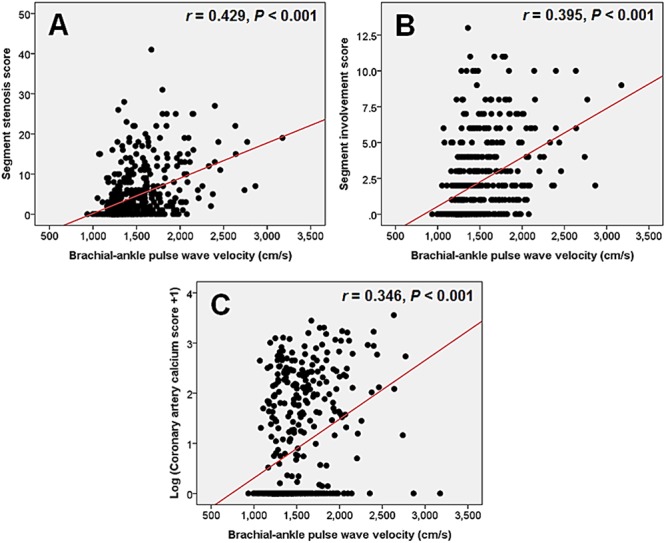
The associations between brachial-ankle pulse wave velocity and severity of coronary artery disease.Graphs show the associations of baPWV with segment stenosis score (A), segment involvement score (B), and coronary artery calcium score (C).